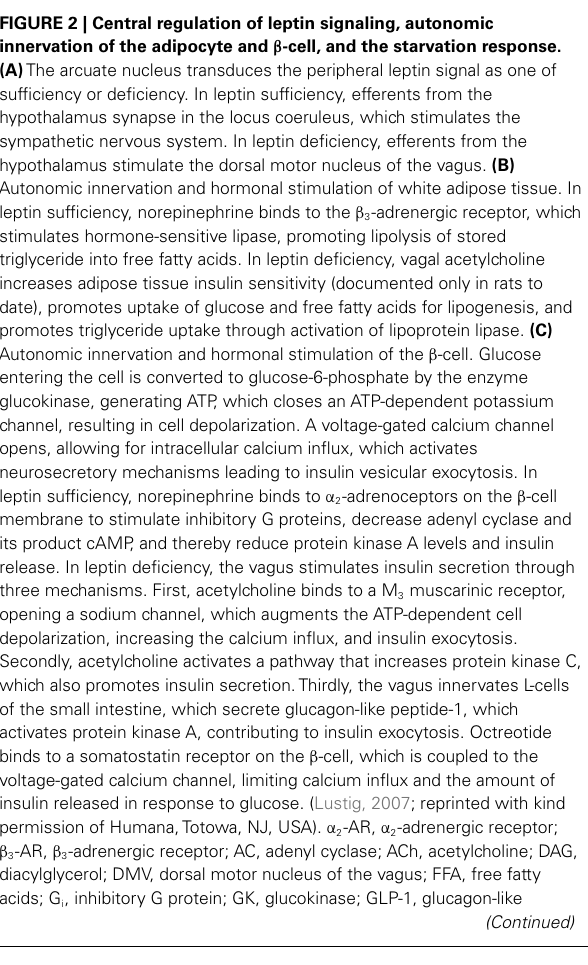
FIGURE 2 | Continued peptide-1; GLP-1R, GLP-1 receptor; Glu-6-PO 4 , glucose-6-phosphate; Glut4, glucose transporter-4; HSL, hormone-sensitive lipase; IML, intermediolateral cell column; IP 3 , inositol triphosphate; LC, locus coeruleus; LHA, lateral hypothalamic area; LPL, lipoprotein lipase; MARCKS, myristoylated alanine-rich protein kinase C substrate; NE, norepinephrine; PIP 2 , phosphatidylinositol; PKA, protein kinase A; PKC, protein kinase C; PLC, phospholipase C; PVN, paraventricular